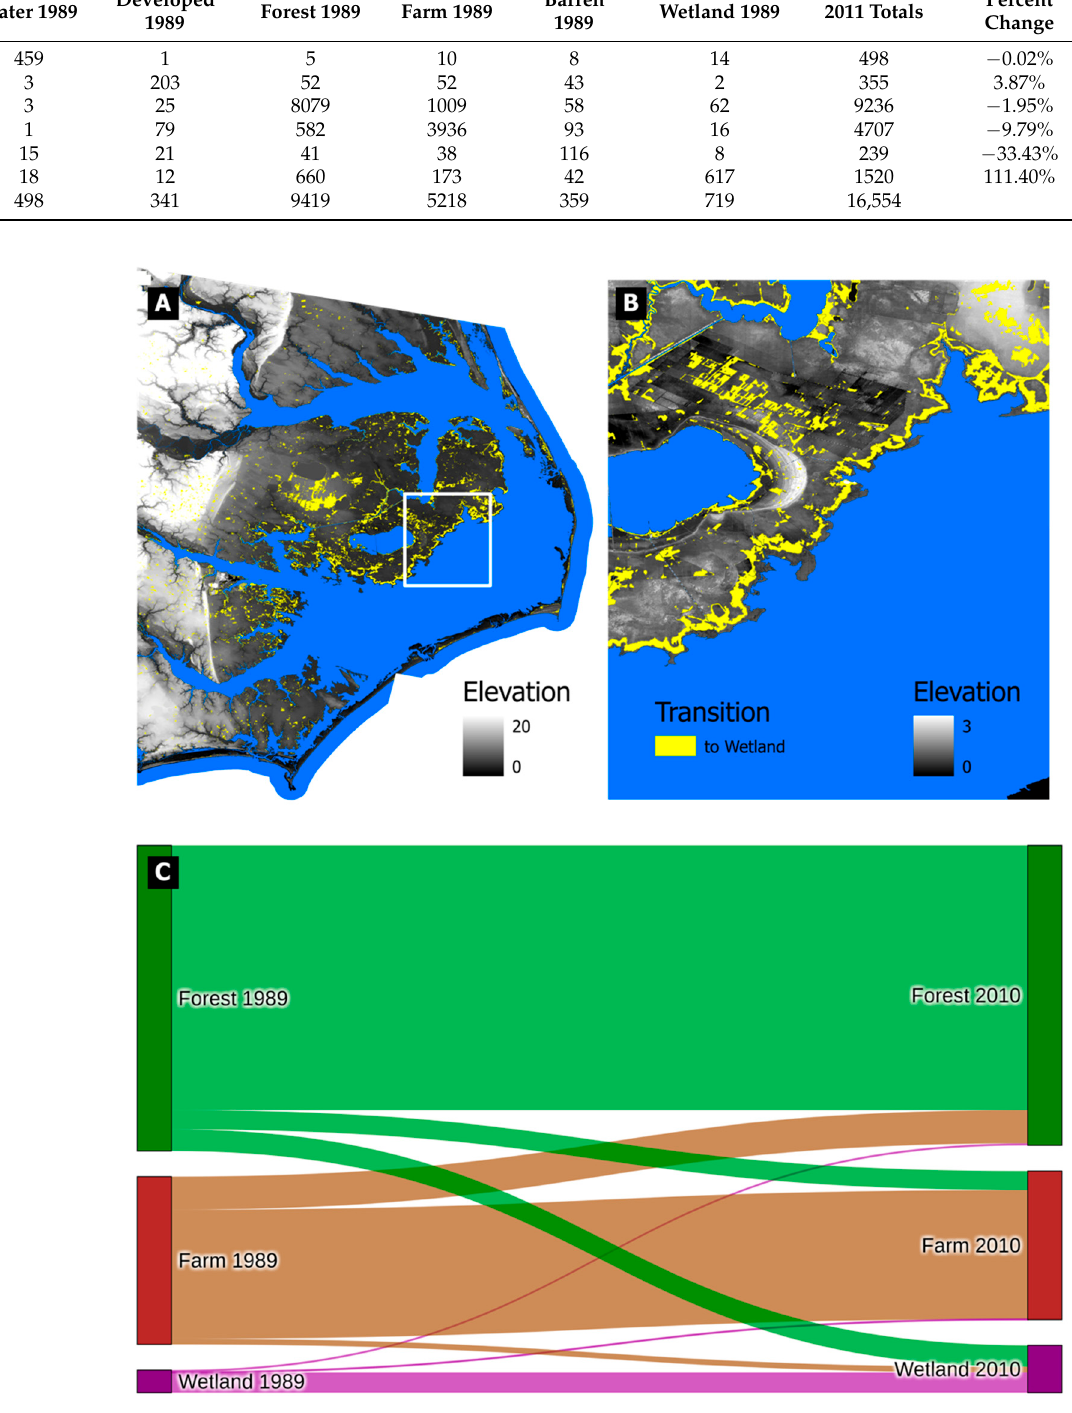
Figure 8. Panels ( A , B ) show in yellow the pixels that were classified as forest or agriculture in 1989 but as wetland in 2011 overlaid on a map of elevation. Panel ( C ) shows the quantity of pixels that transitioned between forest, agriculture, and wetland from 1989 to